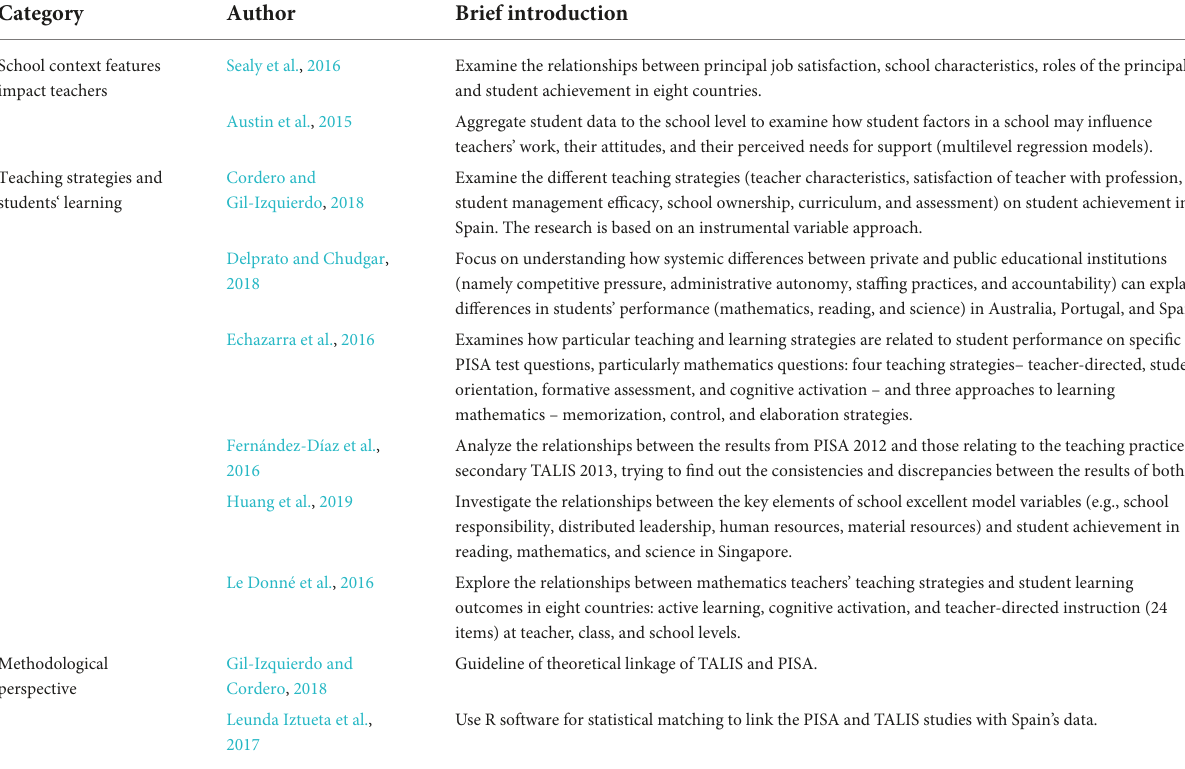
TABLE 1 Overview of papers using the linkage data from teaching and learning international survey-programme for international student assessment (TALIS-PISA) Link 2013 and PISA